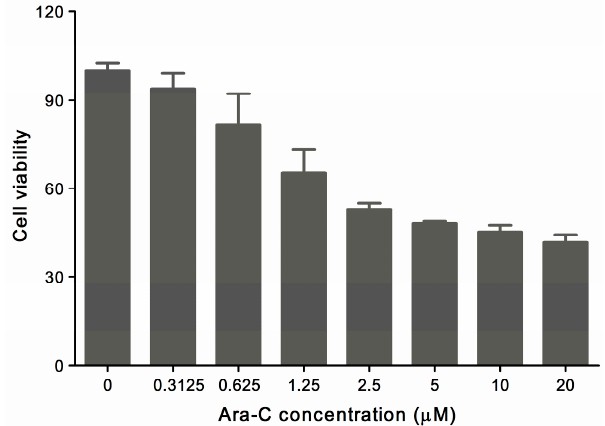
Figure 2. The cytotoxicity of Ara-C on HL-60 cells at different concentrations after 24 h treatment ( n = 6).